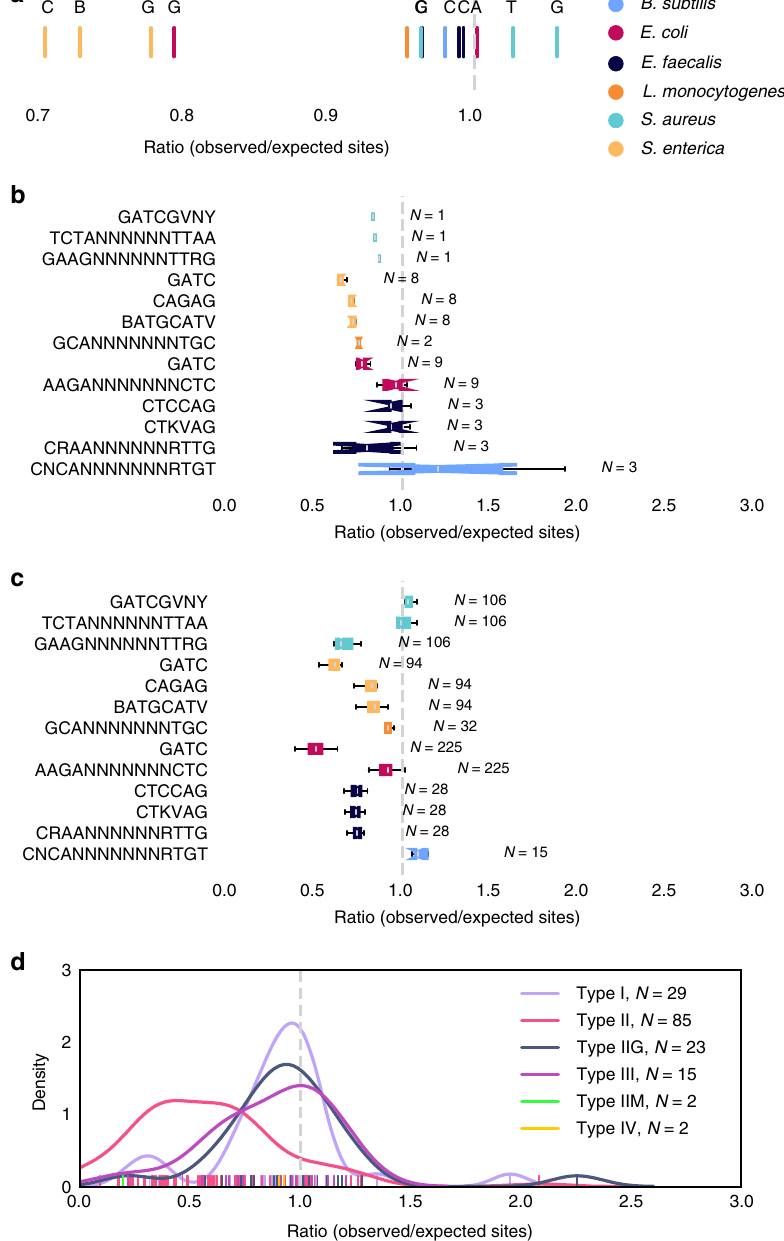
Fig. 5 Methylated motif depletion. Ratio of observed over expected motif counts calculated by maximal order Markov model a in assembled genomes, colored by species and labeled by fi rst nucleotide where there were multiple motifs for a species, b in predicted prophages within assembled genomes, and c in viruses associated with each species. d The distributions of ratios for different types of restriction-modi fi cation system across viruses associated with different species in the REBASE database. Boxplot center lines show medians, notches con fi dence intervals, and whiskers 1.5x interquartile